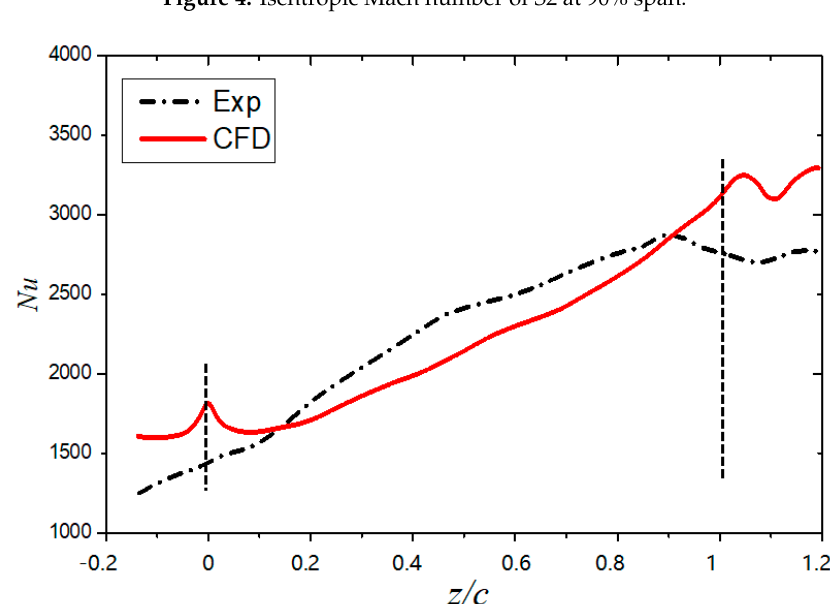
Figure 5. Nu distribution of S2 shroud.